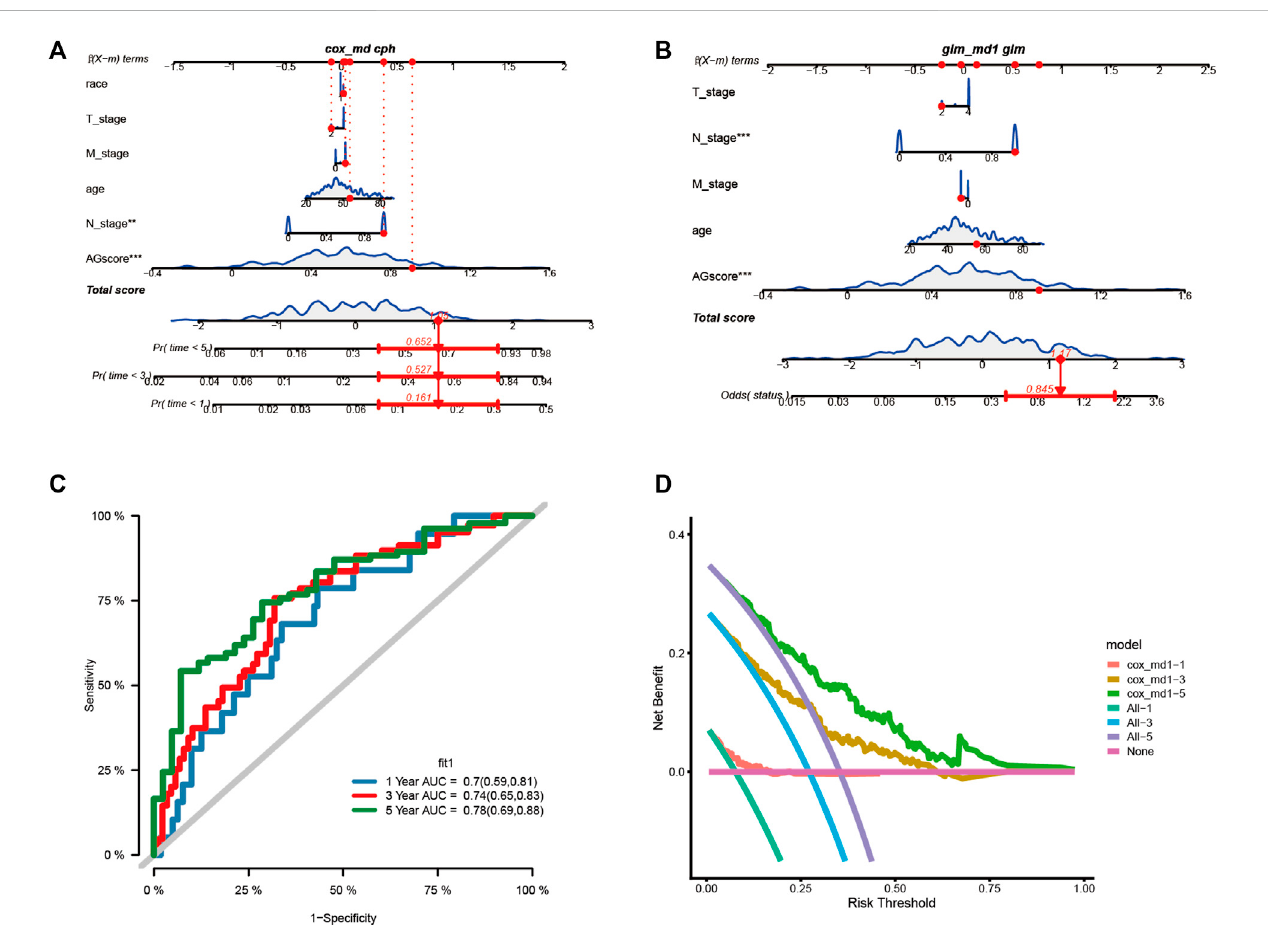
FIGURE 6 Construction the nomogram and decision curve analysis. (A) . Construction nomogram to predict 1-, 3-, and 5-year clinical outcome by cox regression. (B) . Construction nomogram to predict status of patients by logistic regression. (C) . ROC curve of the nomogram. (D) . Decision curve analysis. (* < 0.05, ** < 0.01, *** <